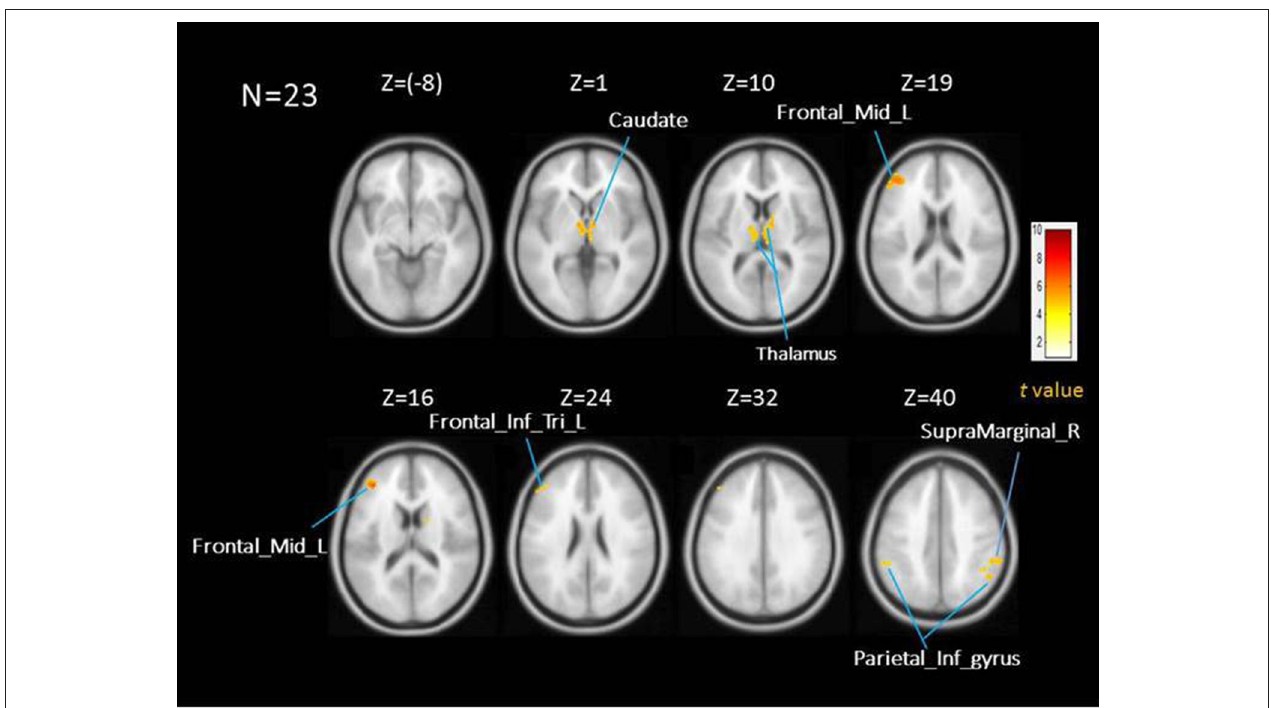
FIGURE 1 | Averaed brain activation map showing the main effect of repsiratory occlusions under AlphaSim corrected p < 0.05; time and dispersion derivatives. Areas activated include thalamus, caudate, middle frontal cortex, inferior frontal triangularious, and inferior parietal cortex. events of inspiratory occlusions. The main activated brain regions were the right inferior parietal lobe, left middle frontal gyrus, left thalamus, and left inferior parietal lobe (Alpha Sim corrected p < 0.05).